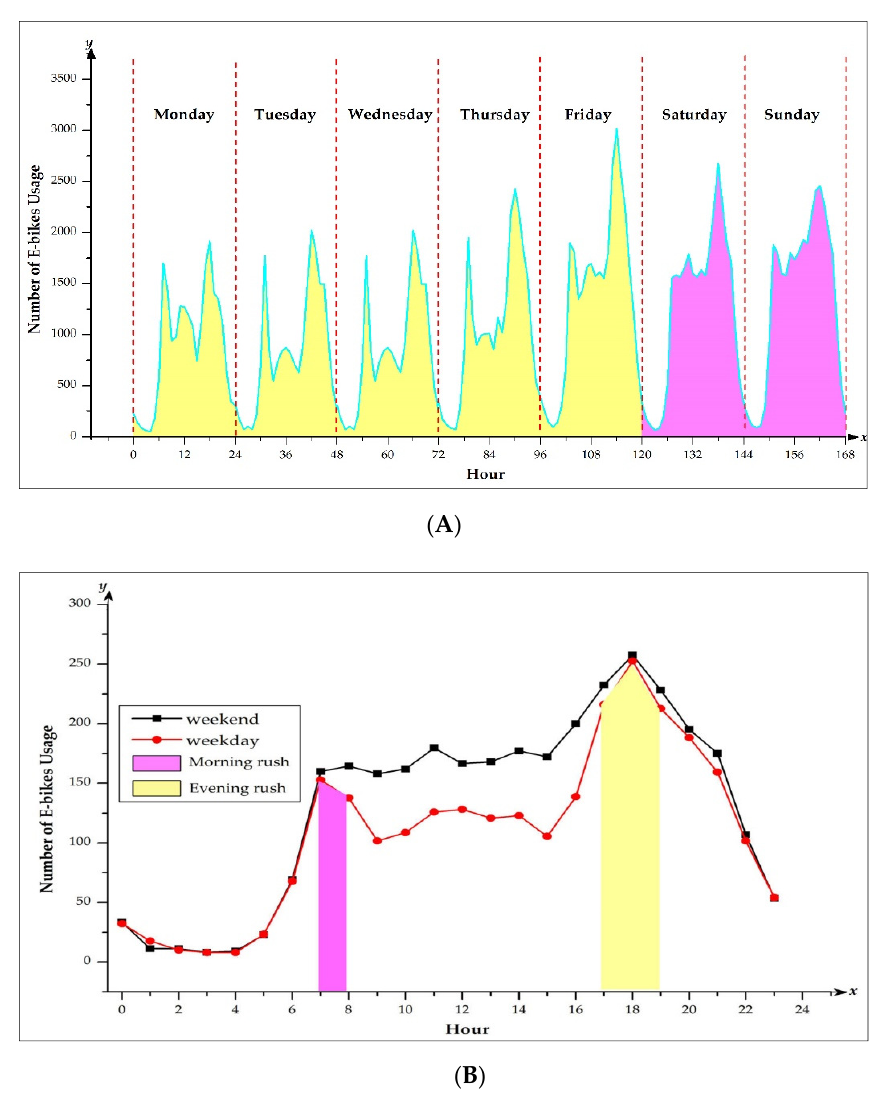
Figure 3. Hourly distribution of e-bikes daily usage. ( a ) Hourly distribution of e-bike daily usage from Monday to Sunday. ( b ) Hourly distribution of e-bike average daily usage on weekdays and weekends.